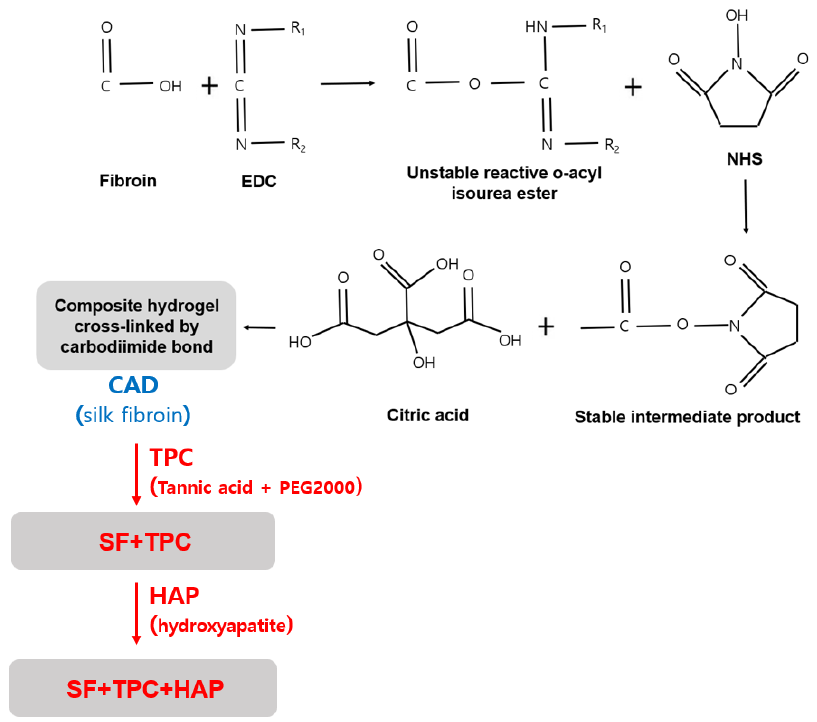
Figure 1. A schematic summary of two bioadhesives.